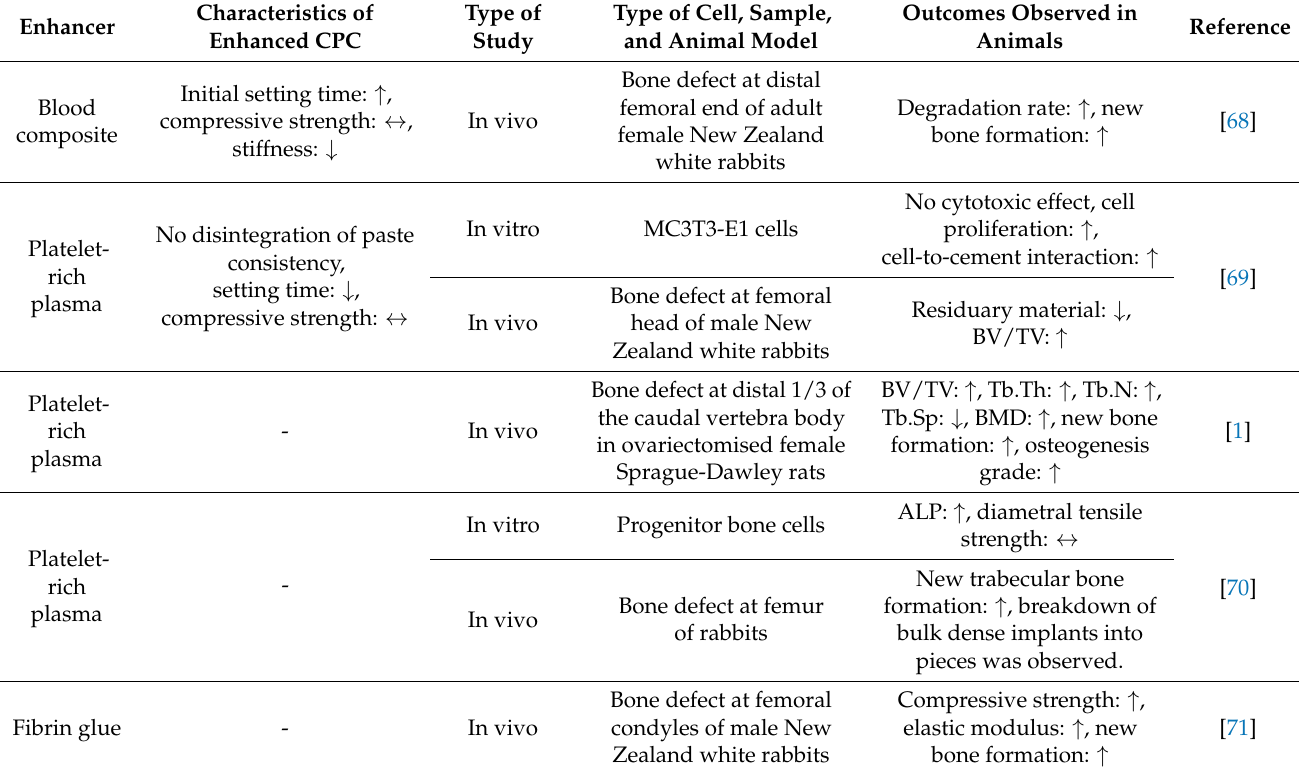
Table 5. The bone protecting effects of CPC enhanced by blood